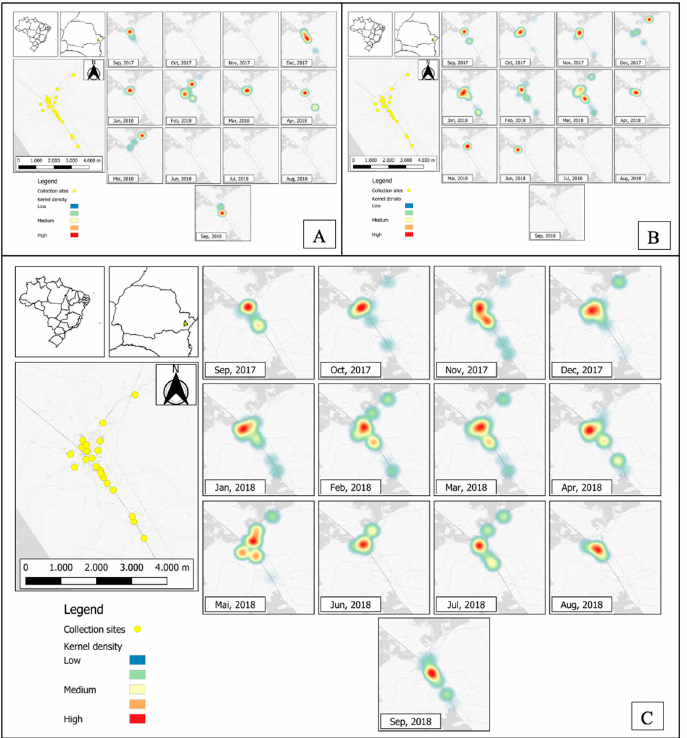
Figure 3. ( A ) Temporal and spatial distribution of Ae. aegypti identified from collected eggs; ( B ) Temporal and spatial distribution of Ae. albopictus identified from collected eggs; ( C ) Kernel map showing the occurrence of eggs collected in the 23 selected points, Morretes, Paraná, Brazil. Table 1. Collections sites in the municipality of Morretes, September 2017 to September 2018, Paraná, Brazil.